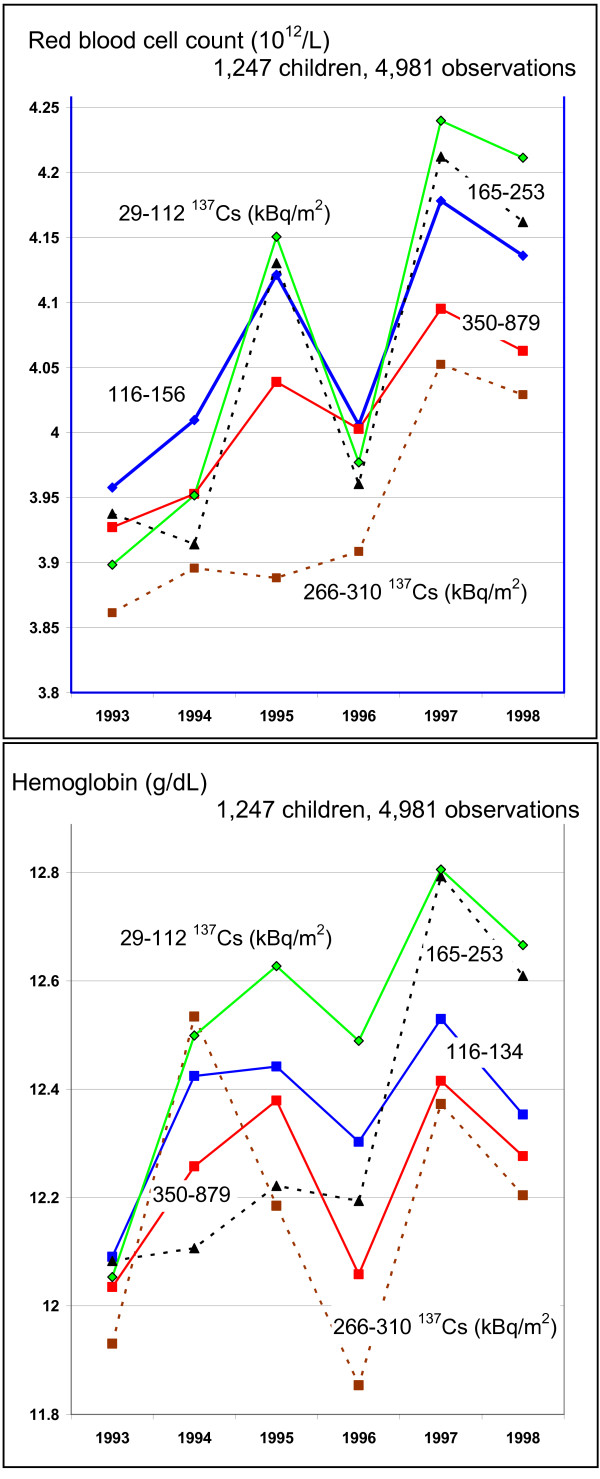
Changes of erythrocyte counts and hemoglobin over the years of observations by 137Cs exposure. The 137Cs contamination is grouped into quintiles. For hemoglobin: 1 g/dL equals about 0.6206 mmol/L.